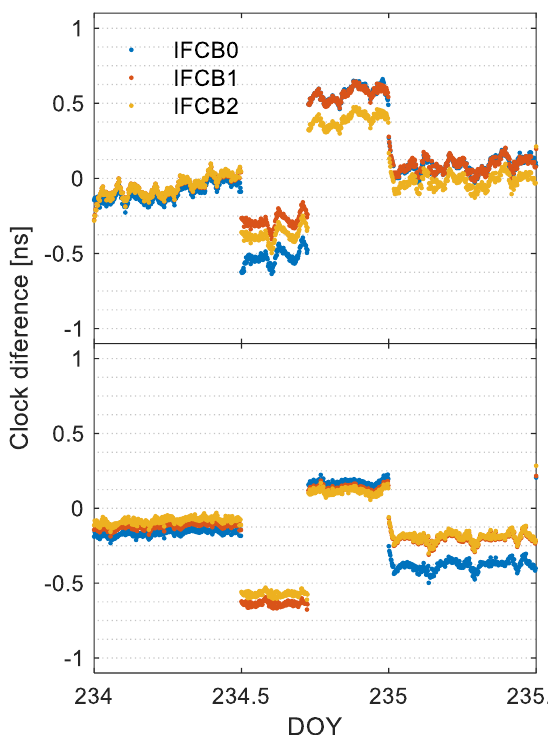
Figure 9. The clock differences of the one-day arc solutions at AGGO-PT11 and BRUX-PT11 at DOY 235, 2017, in three handling schemes.